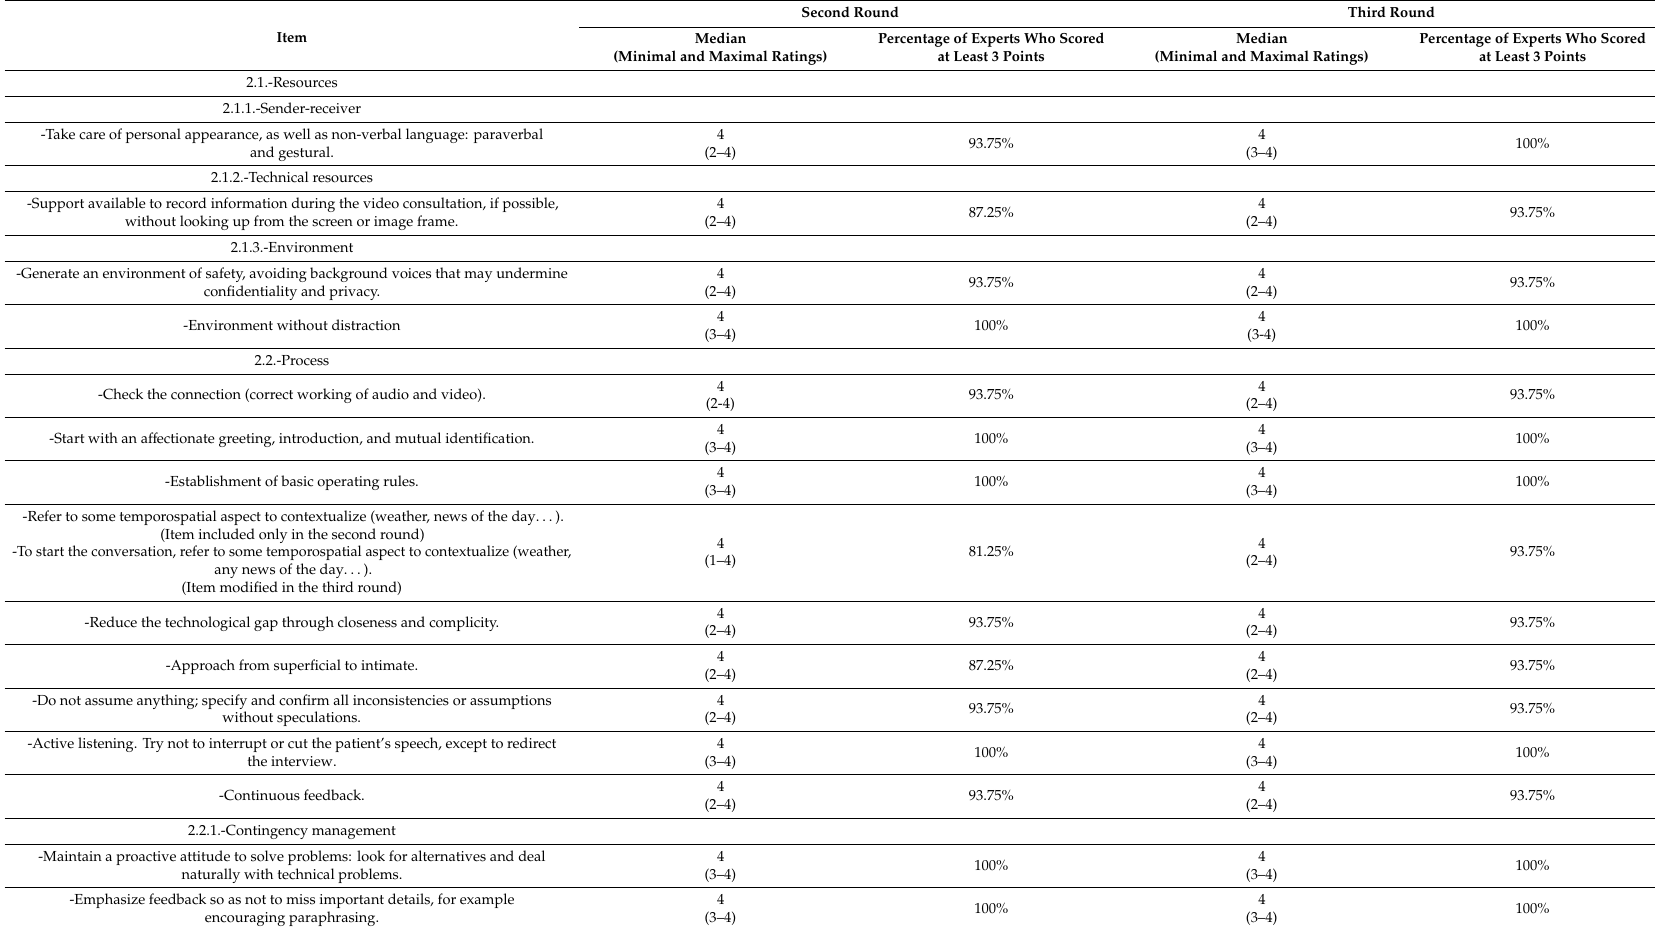
Table 3. Results of Delphi method: video consultation